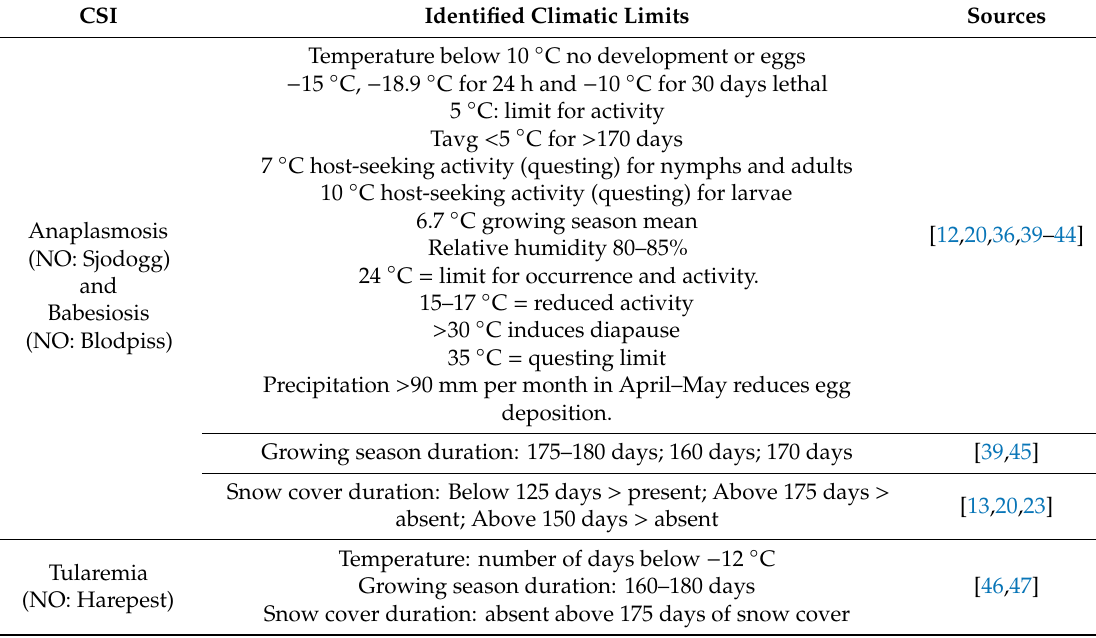
Table 1. Climatic criteria for the absence, prevalence or spread of the focus zoonoses by their vectors. CSI Identified Climatic